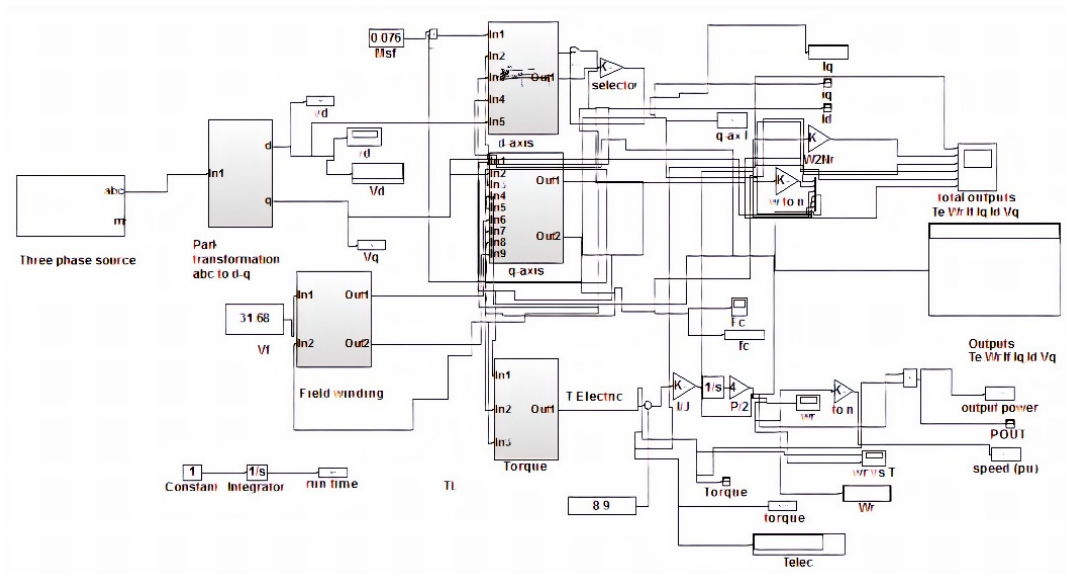
Figure 18. HEPMSM simulation model.